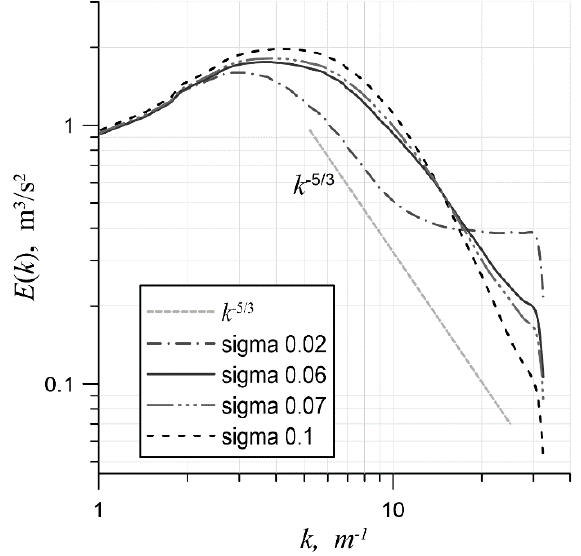
Figure 10. The energy spectra in a series of ILES at various constant values of σ on a mesh with 64 3 cells.